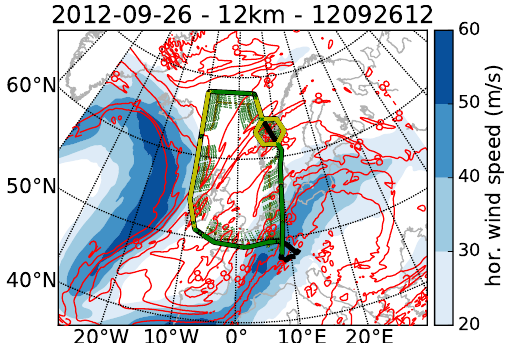
Figure 2. The synoptic situation during the flight of 26 Septem- ber 2012. The flight path is marked as black line, the flight di- rection is clock-wise. Atmospheric measurements of GLORIA are Figure 3. A measured and a simulated dynamics mode spectrum Figure 3. A measured and a simulated dynamics mode spectrum averaged over row 57 (tangent altitude overlayed in green and yellow for chemistry and dynamics mode, 12.78 km ) of the detector taken at 14:40:12 (UTC) and 14.45 km aircraft altitude. The spectrum is split averaged over row 57 (tangent altitude 12.78km) of the detector respectively. The tangent points of processed profiles are shown at 1090 cm − 1 with the lower panels showing higher wavenumbers. The lines shows the full spectral taken at 14:40:12UTC and 14.45km aircraft altitude. The spec- resolution of the spectra while the markers show the values of the ISWs used in the retrieval. The extent in green, where the tangent point vertically closest to 12km is trum is split at 1090cm − 1 with the lower panels showing higher of the ISWs is overlayed as grey bars. The difference plots also contain the target (dots) and threshold highlighted in yellow. Isolines of potential vorticity are shown in (dashes) values for noise. This simulation was performed using the band model. The large discrepancy wavenumbers. The lines shows the full spectral resolution of the red. Wind speeds are shown as contour surfaces in blue shades. in the lower panels is caused by N 2 O and CH 4 , which are currently not retrieval targets spectra while the markers show the values of the ISWs used in the retrieval. The extent of the ISWs is overlayed as grey bars. The dif- ference plots also contain the target (dots) and threshold (dashes) values for noise. The vertical red lines separate regions that employ different aerosol/extinction profiles. This simulation was performed using the band model. The large discrepancy in the lower panels is caused by N 2 O and CH 4 , which are currently not retrieval